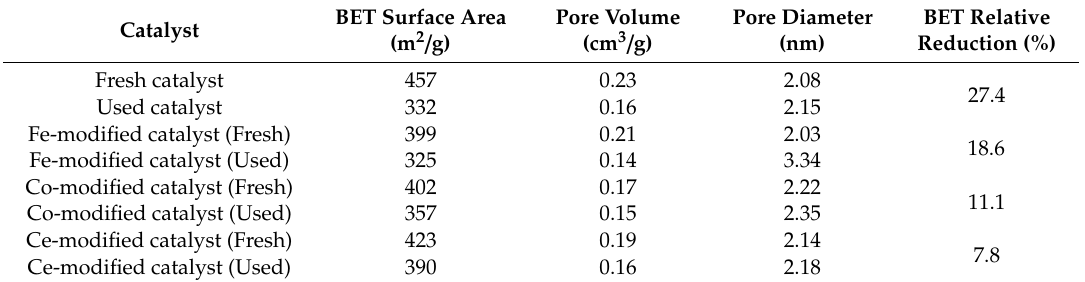
Table 2. BET analysis of the fresh and spent Cu–Mn / SAPO-34 or modified catalyst.